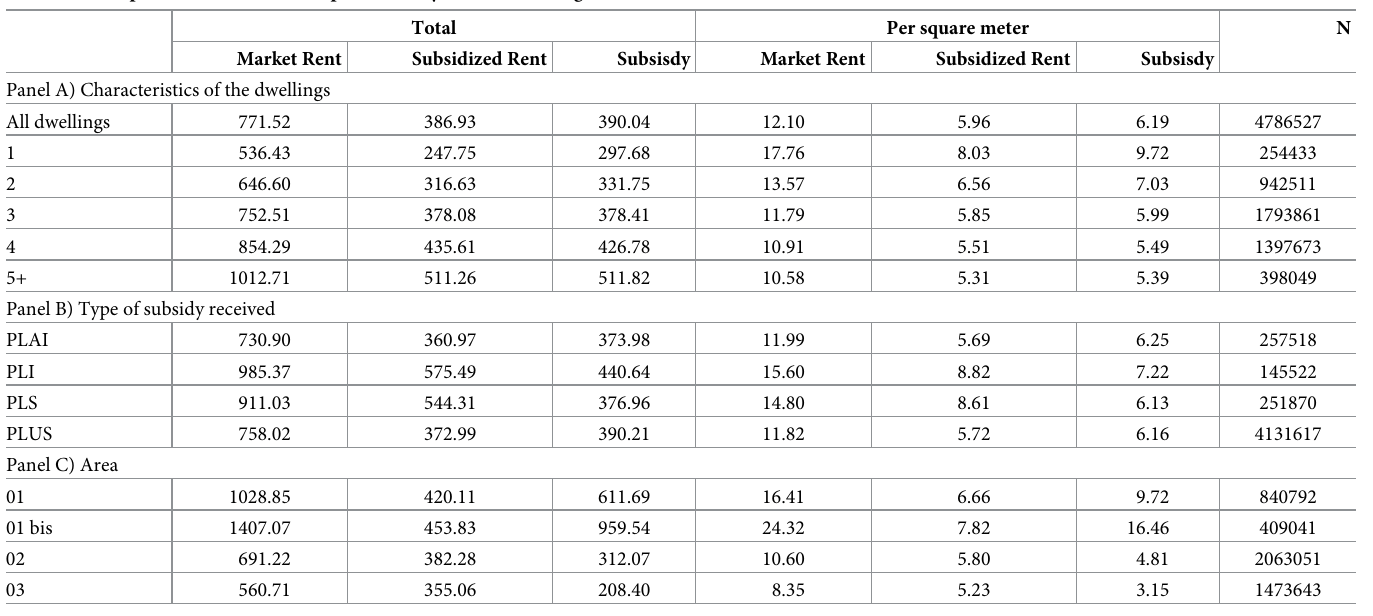
Table 8. Descriptive statistics on the implicit subsidy of social